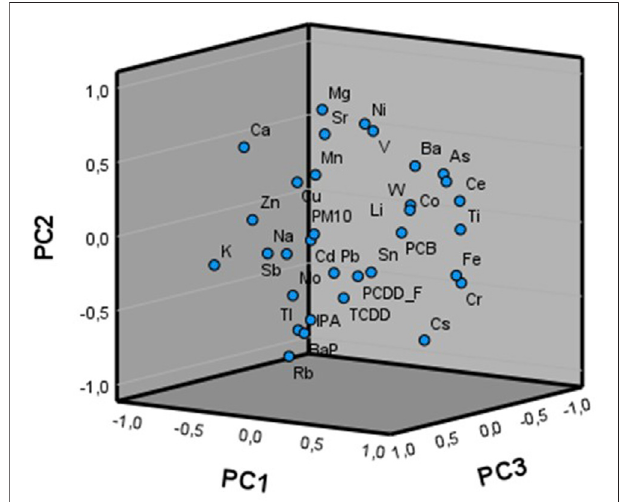
FIGURE 1 | The three-dimensional component plot in rotated